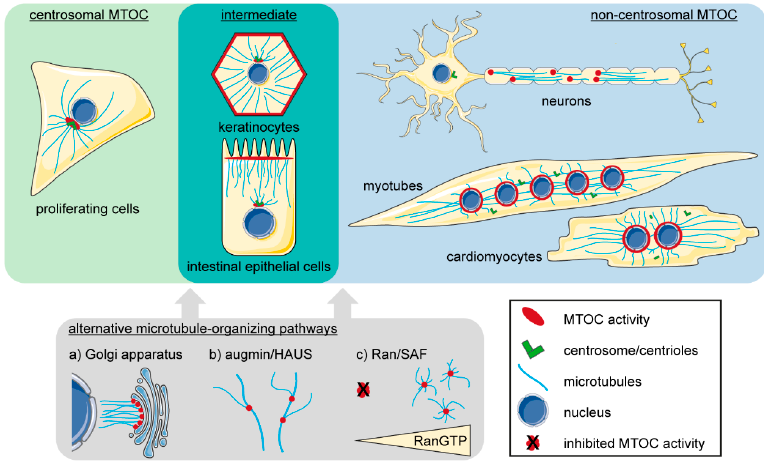
Figure 1. Examples of microtubule organization in animal cells (depictions are simplified; see main text for details). The centrosome is the dominant microtubule-organizing center (MTOC) in proliferating cells (green panel). Di ff erentiated cell types like neurons or striated muscle cells exhibit various non-centrosomal MTOCs and attenuate / inactivate or, as described for cardiomyocytes, disassemble their centrosomes (blue panel). Certain types of epithelial cells are “intermediates”, i.e., they retain microtubule nucleation ability at centrosomes but anchor microtubules mainly at non-centrosomal sites (cyan panel). In addition, several alternative microtubule-organizing pathways (grey panel) are active in proliferating as well as di ff erentiated cells (neurons in particular) that act in synergy with the dominant